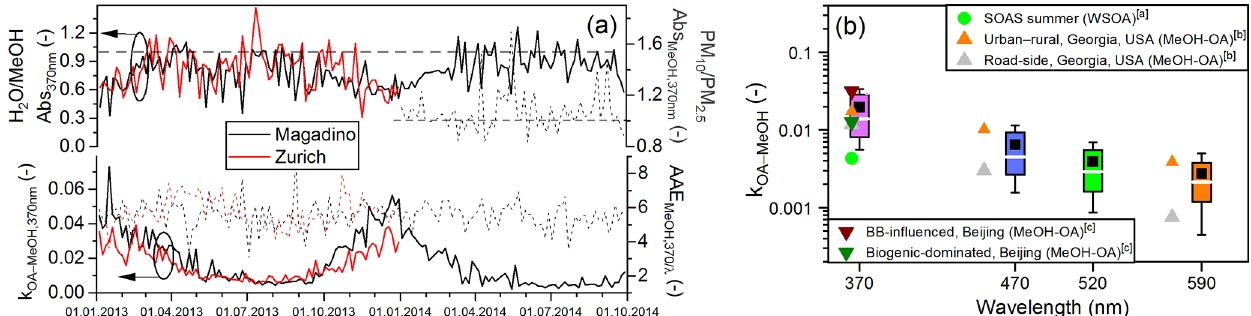
Figure 1. (a) Time series at 370nm of the water-to-methanol absorbance ( A , or Abs) ratio (not corrected here for the solvent effect) and the PM 10 -to-PM 2 . 5 absorbance ratio in methanol (horizontal dashed lines indicate ratios of 1.0) as well as the imaginary part of refractive index ( k ) of the bulk methanol-extracted organics (Eq. 2) and the AAE MeOH , 370 /λ ( λ = 470 / 520 / 590nm). The OA mass from AMS–PMF Solution 2 was used for all 2013 data for a direct comparison between Magadino and Zurich. (a) Box plots of the bulk mixed-source UV– vis-based k OA (total extractable OA, homogeneous and internally mixed without any inorganics or BC present) at four AE33 wavelengths for all 245 PM 10 samples measured from Magadino and Zurich (white line and box: median and IQR; black squares and whiskers: mean and 1 standard deviation (SD)) compared to selected literature values for bulk extracted OA: (a) Washenfelder et al. (2015), (b) Liu et al. (2013), (c) Cheng et al. (2017). SOAS: “The Southern Oxidant and Aerosol Study”.